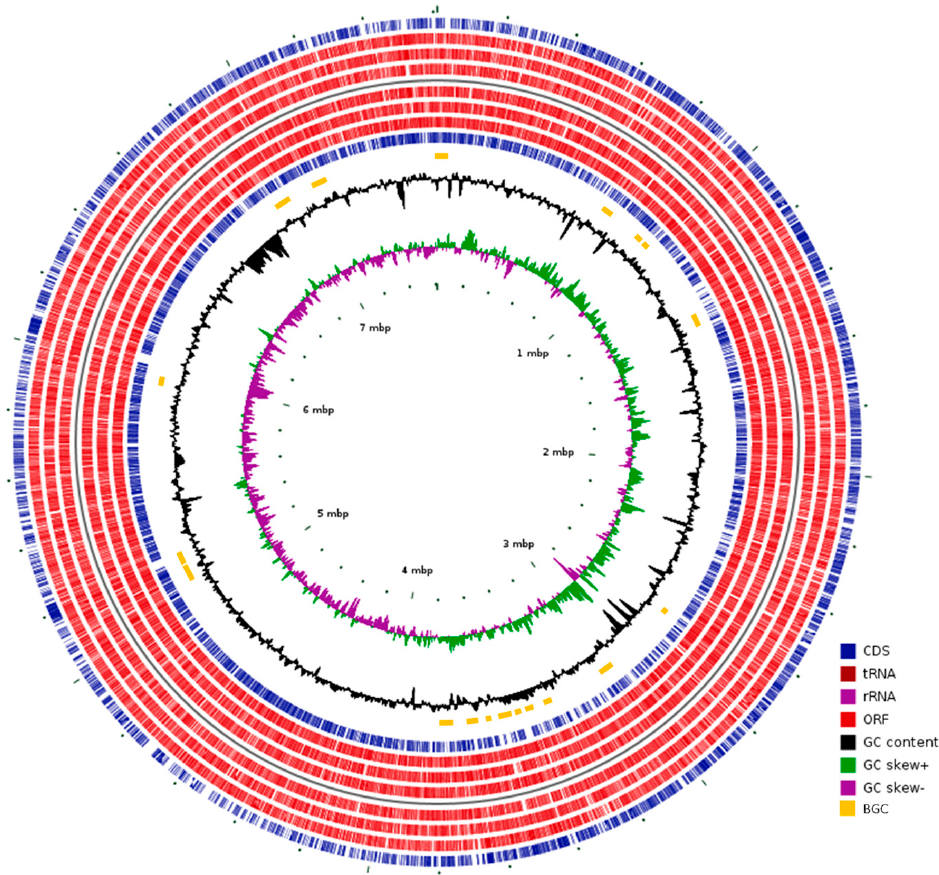
Figure 2. Graphical circular map of the chromosome of Kribbella sp. CA-293567 showing, from inner to outer layers, GC skew, GC content, location of BGCs, ORFs and CDSs in the reverse strand, and ORFs and CDSs in the forward strand.